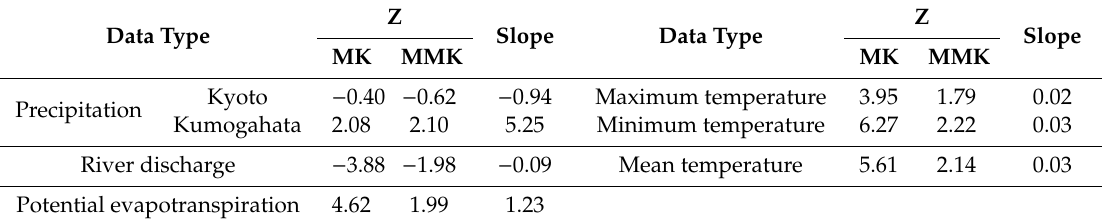
Table 2. Results of trend analysis in annual hydroclimatic variables from 1962 to 2017.